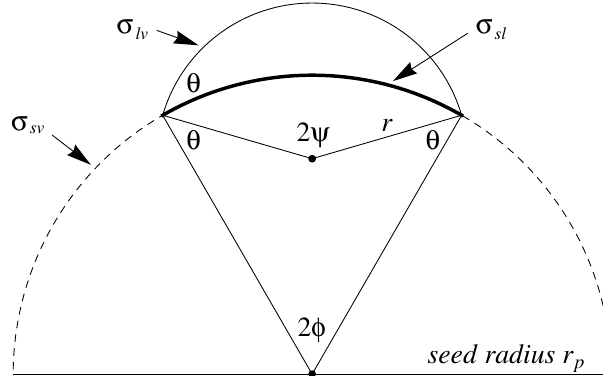
Figure 2. Same as Fig. 1 after units conversion from S to n 1 (cm − 3 ). In passing from Fig. 1 to Fig. 2, the nucleation probability curves are shifted horizontally to the right by the factor n T ( ) eq highest temperature with the result that the probability curve at 287 K overtakes the two at lower temperatures to give the reordering seen in the figure.